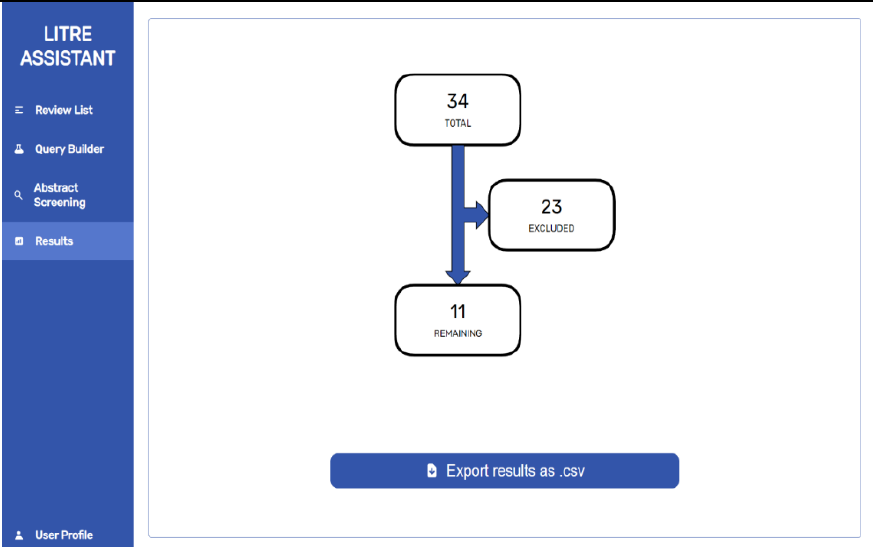
Figure 9. Results feature of the Litre Assistant system showing complete literature results, including the chart and data export features.